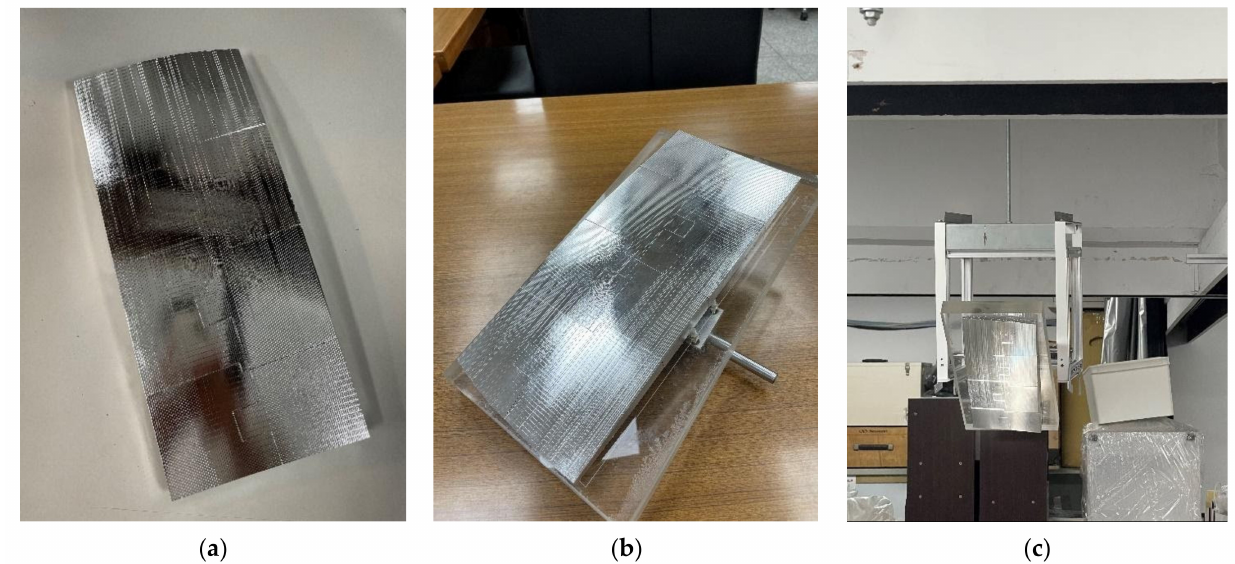
Figure 19. ( a ) Aluminum-coated freeform reflector; ( b ) mirror glued on an acrylic backboard; and ( c ) freeform reflector module installed in the